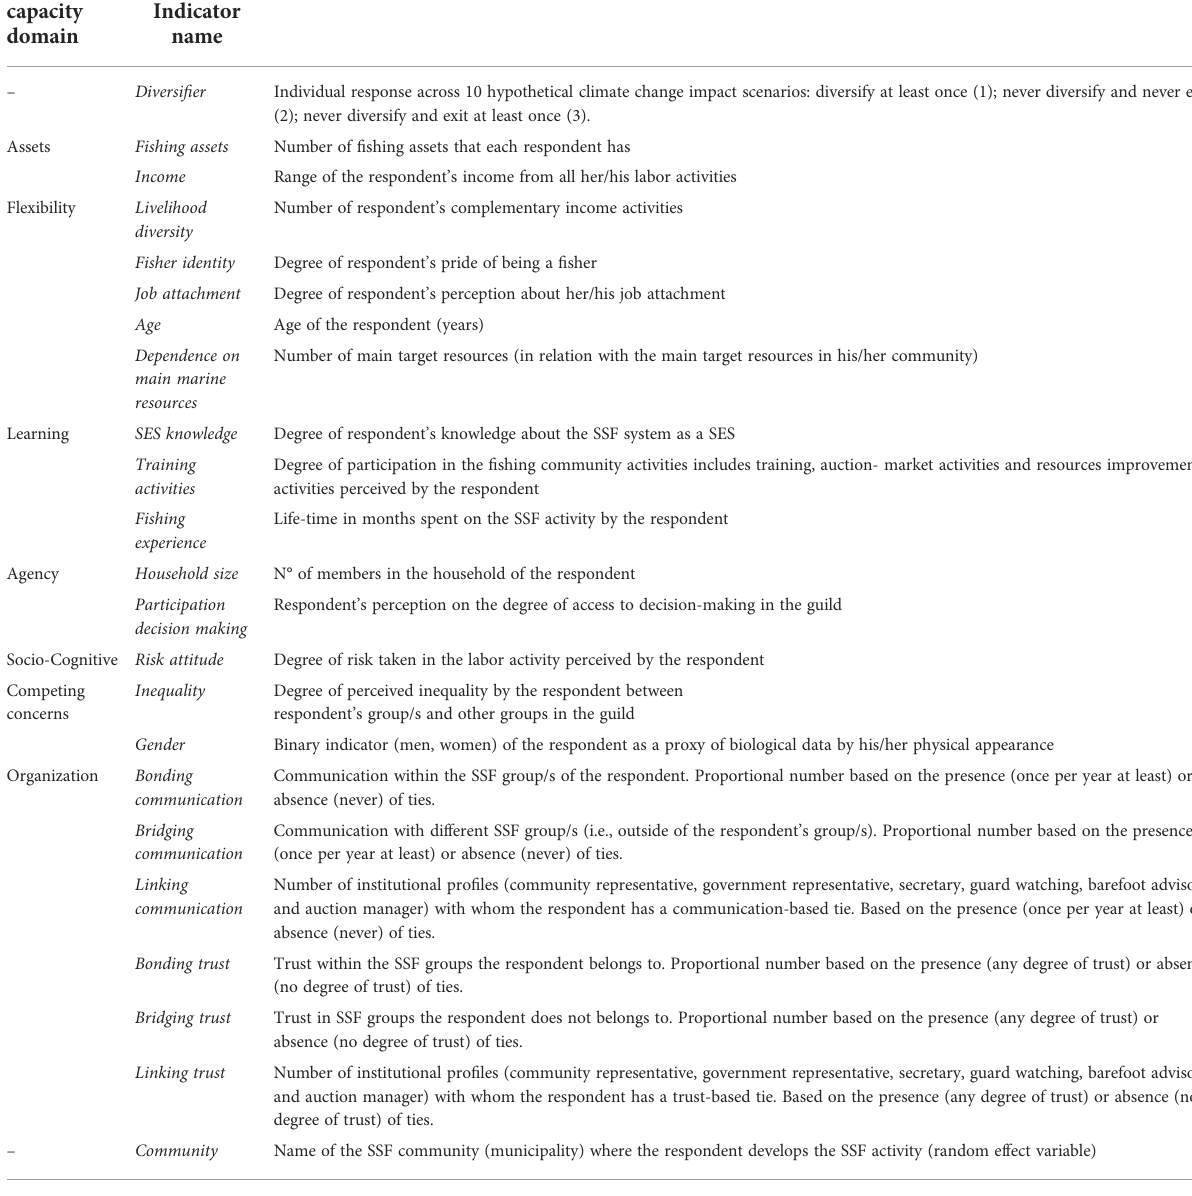
TABLE 1 Dependent and independent variables used for the multinomial multilevel logit mixed effect model. Adaptive